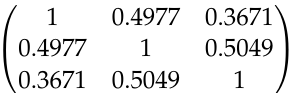
Table 2. Summary statistics of simulation